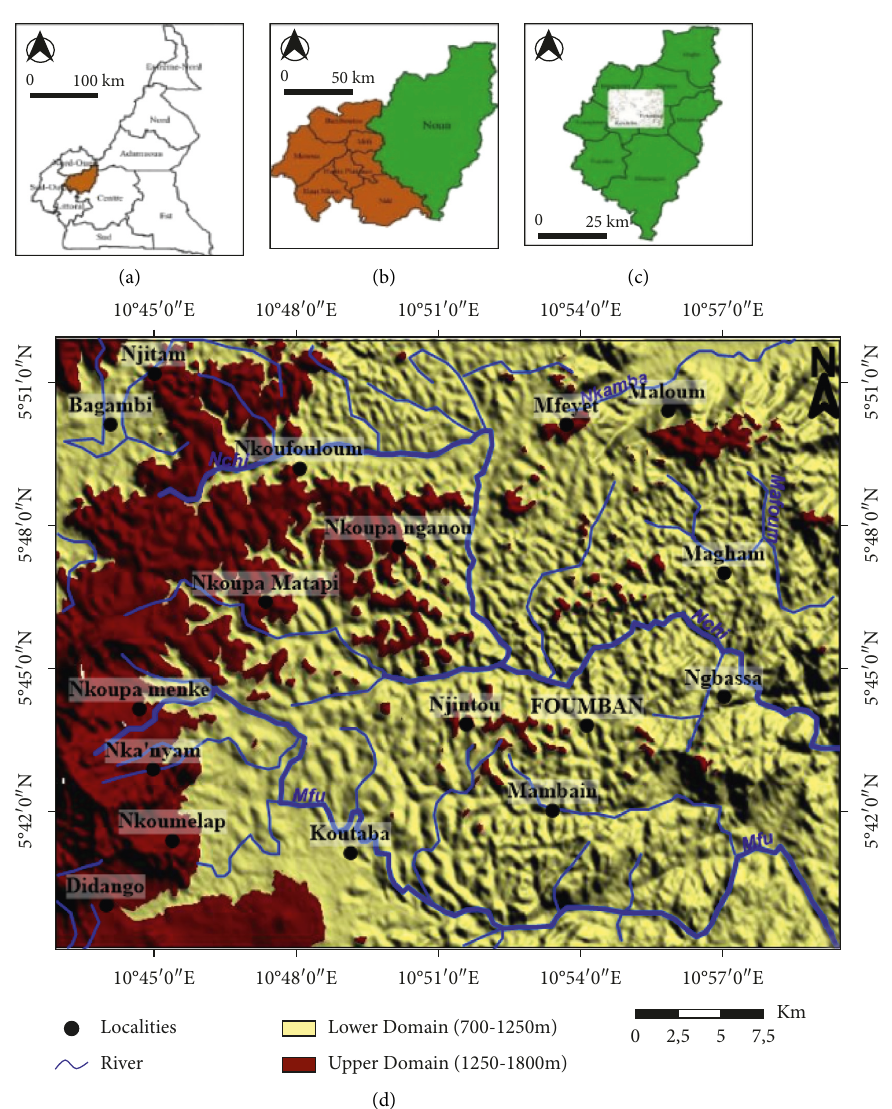
Figure 1: Study area. (a) Map of Cameroon, (b) western region, (c) Noun Department, and (d) location and morphology of the study